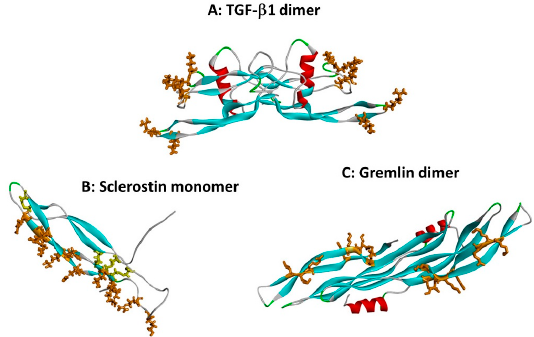
Figure 2. Heparin binding sites on TGF- β superfamily cytokines. Protein chains are shown as in Figure 1, and heparin binding site basic residues are shown in brown stick format. ( A ) The dimer of TGF- β 1 (co-ordinates from 1KLC.pdb). Residues K25, R26, K31, K37, R94 and R97 form a discontinuous heparin binding site at the tips of the “fingers” [13]. ( B ) Sclerostin monomer (one of the NMR ensemble in 2K8P.pdb) with heparin-binding residues in brown. Cystine residues are shown in yellow stick format. Loop 3 (the second β -strand loop) and Loop 2 are both involved; residues K99, R102, R114, R116, R119, R131, R133, K134, R136, K142, K144 and R145 form a linear heparin binding site capable of accommodating a heparin dodecamer [26]. ( C ) The dimer of the CAN BMP antagonist gremlin (co-ordinates from 5AEJ.pdb). Here, the heparin binding residues are located largely along the second “finger”, as for sclerostin; in the dimer both copies of the heparin binding site are on the concave face. Residues K145, K147, K148, K167, K168, K169, K174 and R177 have been identified as forming the heparin binding site [20]. The mode of dimerisation and the location of the heparin binding site both differ from those of TGF- β